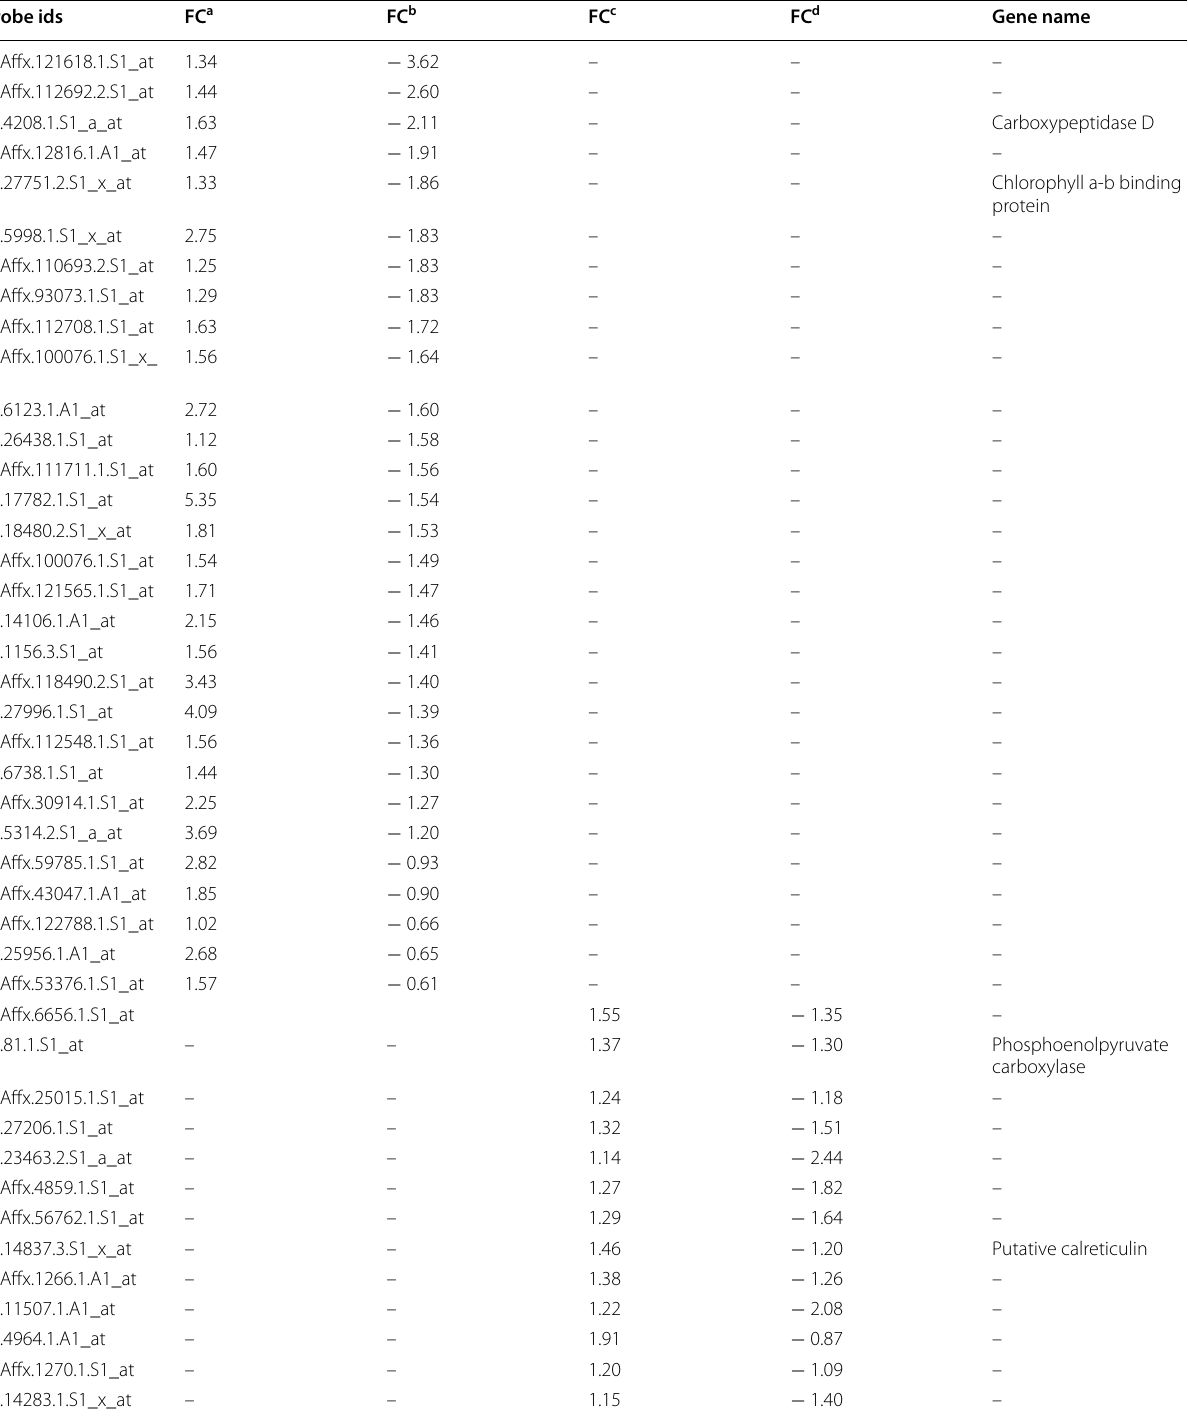
Table 3 Probe ids that have dissimilar DEGs expression in sensitive and tolerant